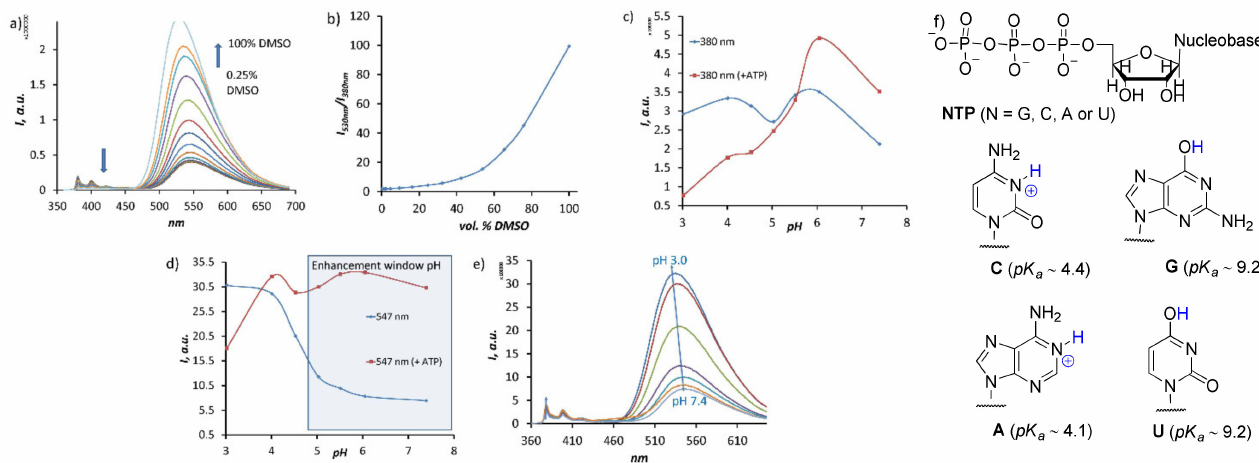
Figure 2. ( a ) Fluorescence changes, observed during the dilution of DMSO solution, of 7 (0.01 mM) with a 10-mM TRIS buffer. Conditions: pH 7.4, 100 mM NaCl, ex: 350 nm. ( b ) Changes in intensity ratio I 530nm /I 380nm with increasing amounts of DMSO portion. ( c,d ) Intensity–pH ratio detected at 380 and 547 nm, respectively. ( e ) Fluorescence spectra of 7 (0.01 mM) at different pH values with constant receptor concentration. ( f ) Structures of nucleoside triphosphates together with pK a values of the acidic functions are shown in blue